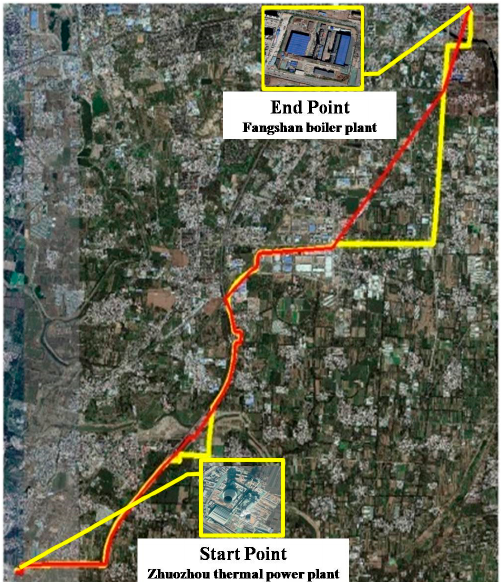
Figure 13. The best route of the modified ACO.